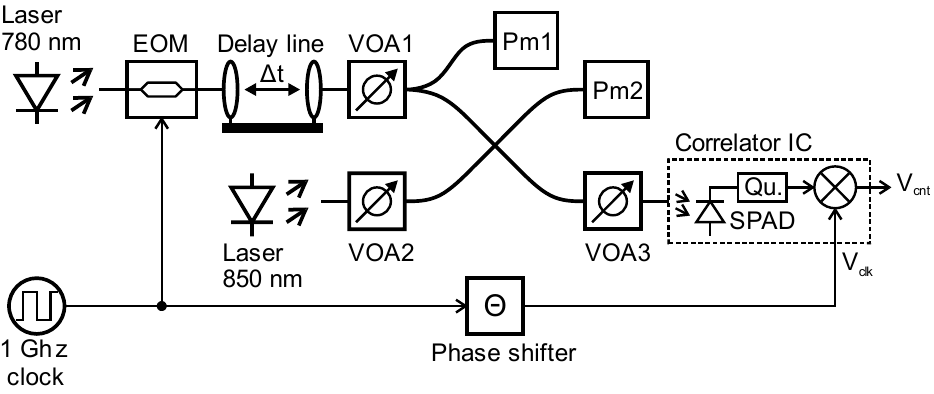
Figure 5. Measurement setup.